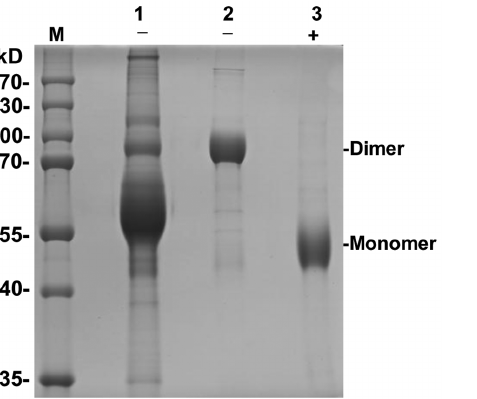
Figure 3. SDS-PAGE analysis of mE2 in culture and purified medium. M, Molecular marker; 1, supernatant of BCSFV-E2; 2 and 3, Immunoaffinity-purified mE2; –, non-reduced; + , reduced with b - mercaptoethanol.